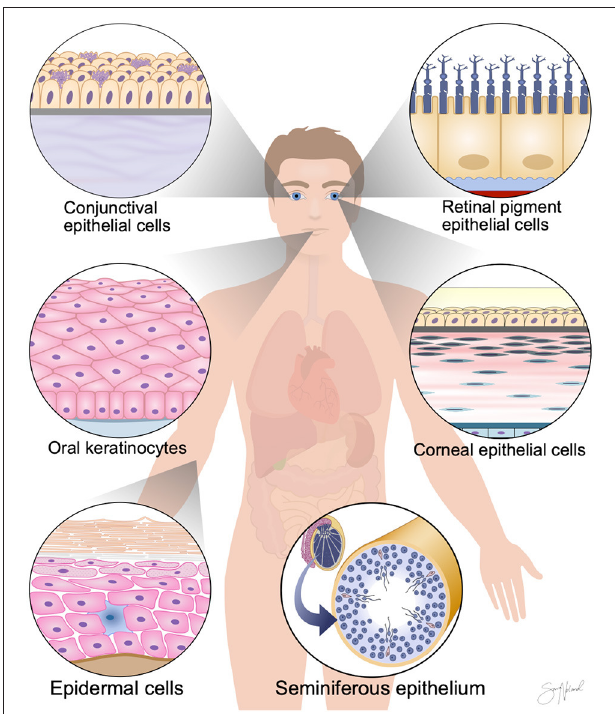
FIGURE 3 | Cell-based regenerative medicine therapies require the development of simple and cost-effective non-freezing preservation methods. Here, we review publications from the last two decades investigating above-freezing point storage of human epithelial cells. The literature search uncovered publications on epidermal cells, retinal pigment epithelial cells, conjunctival epithelial cells, corneal/limbal epithelial cells, oral keratinocytes, and seminiferous epithelial